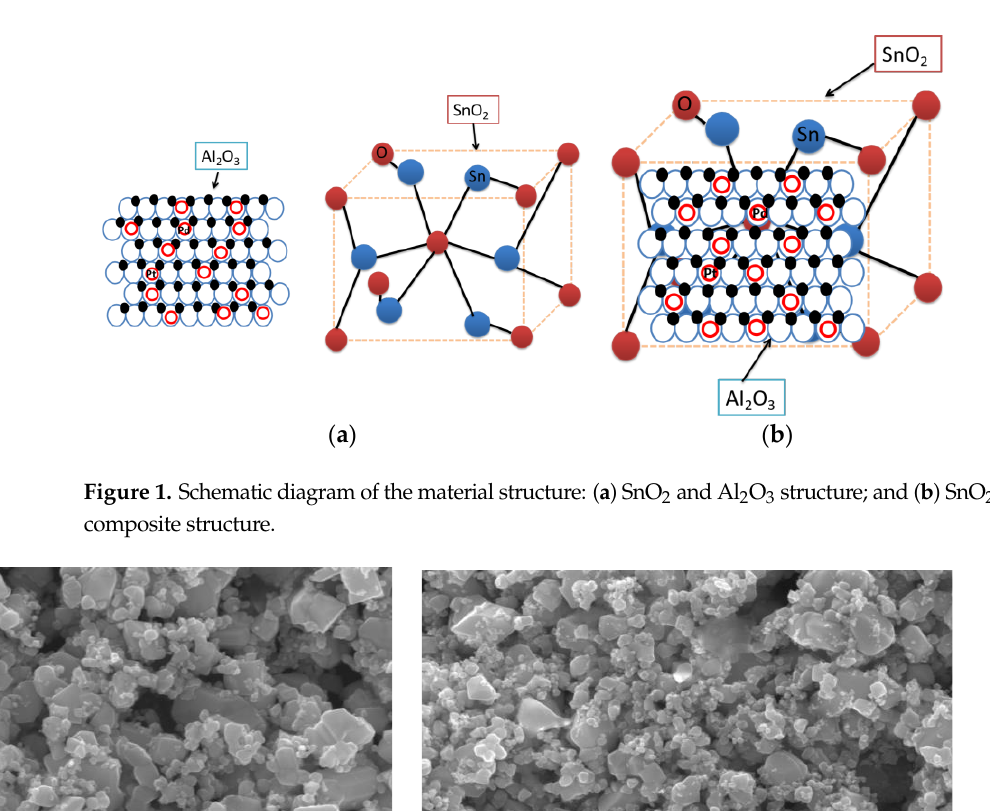
Figure 2. SEM characterization of sensitive films: ( a ) the Pd – Pt/SnO 2 thin film; and ( b ) the Pd – Pt/SnO 2 /Al 2 O 3 thin film.